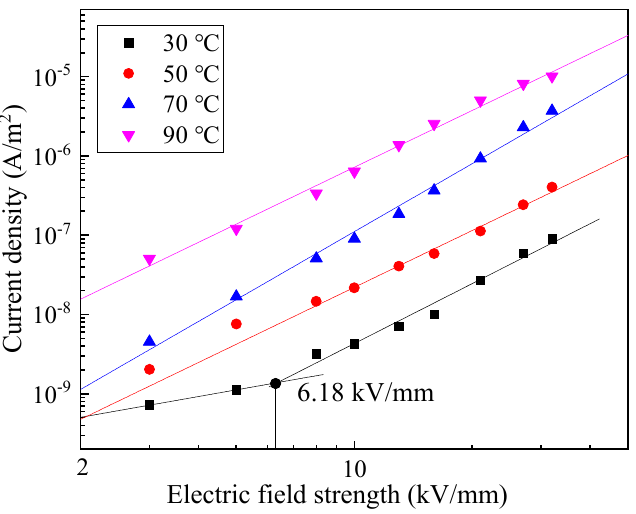
Figure 2. The quasi-steady current density of silicone at different temperatures and fields.